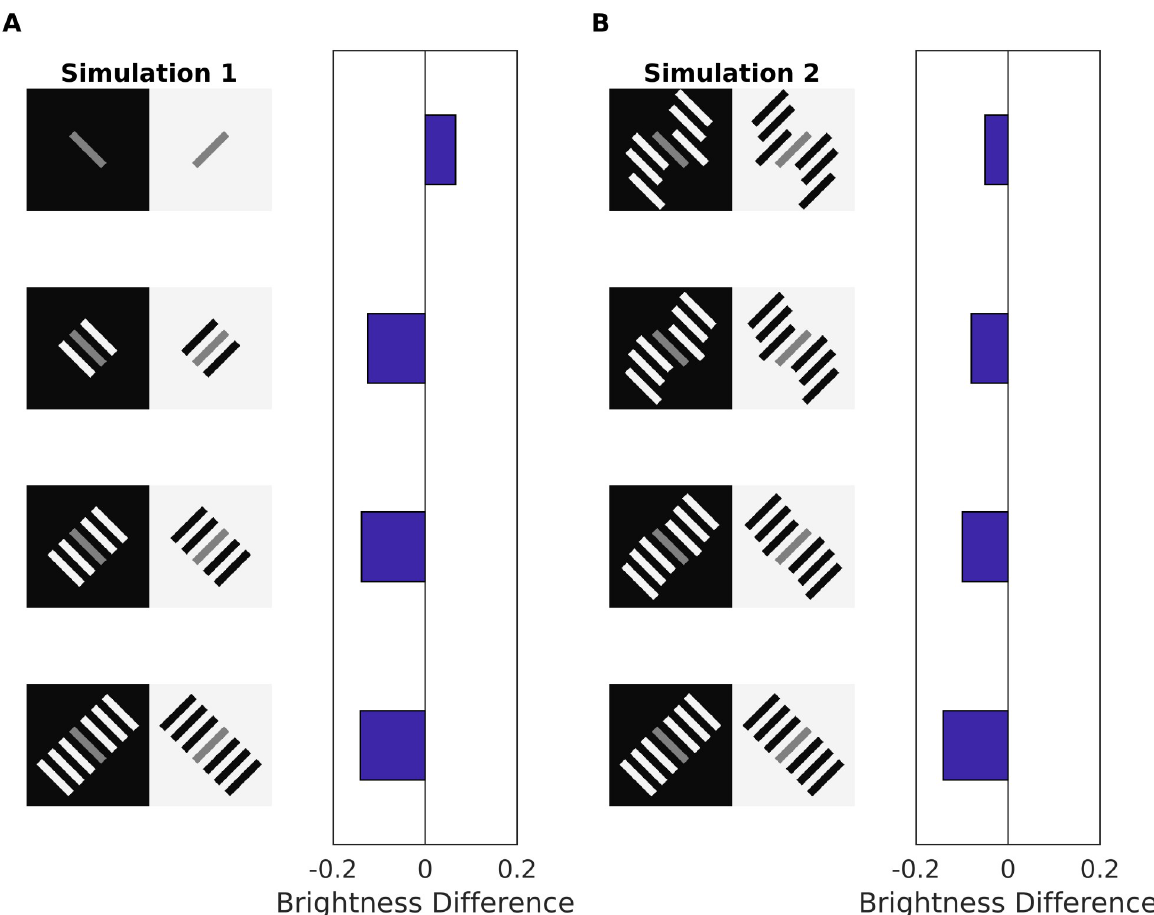
Fig 12. Model prediction for reverse contrast effect for displays with different configurations. (A) Reverse contrast with a varying number of adjacent bars to the gray patch. The bar plots show the predicted brightness difference between the gray patches for the corresponding display (a positive value indicates contrast, while negative values “reverse contrast”). (B) Reverse contrast where the good continuation of the end points is varied. This in turn affect the suppression of redundant edges, which increases with the alignment of the flanking